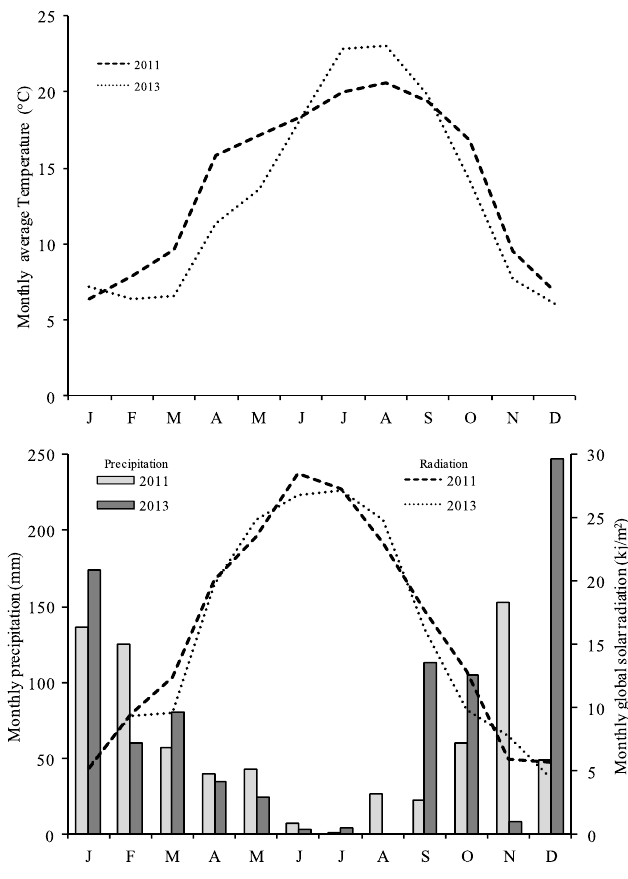
Fig. 1: Average monthly temperature (°C), total monthly precipitation (mm) and global solar radiation (kJ/m 2 ) for 2011 and 2013.